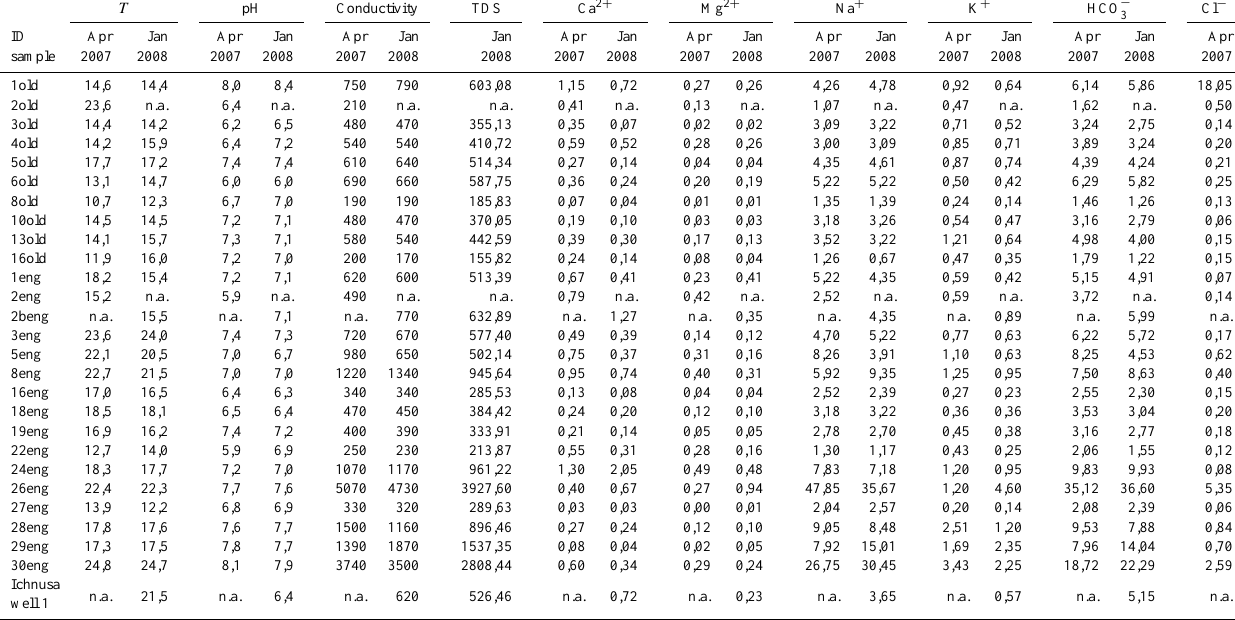
Table 1. Major ion composition of